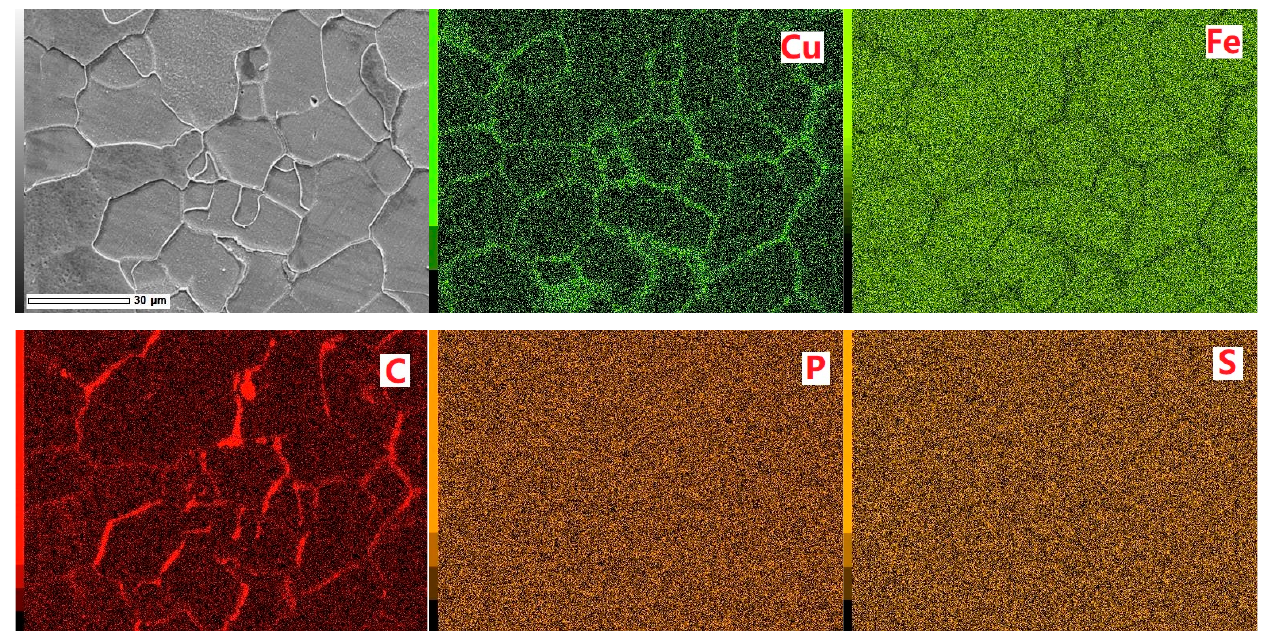
Figure 8. Surface scan results of the steel substrate surface at the Cu–steel interface.